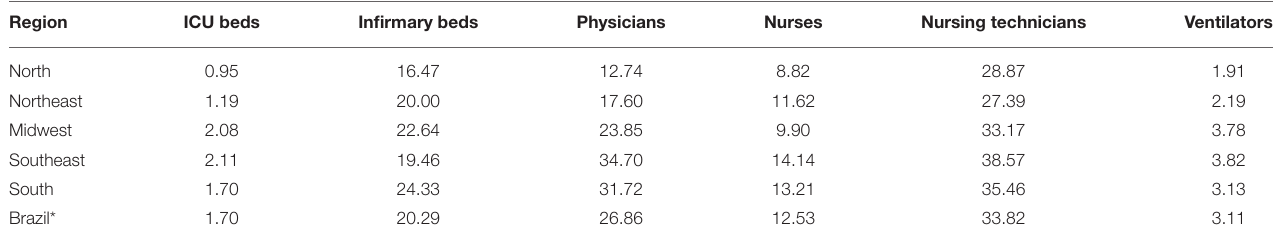
TABLE 2 | Rates of different types of bed and health professionals per population in each region in Brazil * (beds or health professionals/10,000 inhabitants). Region